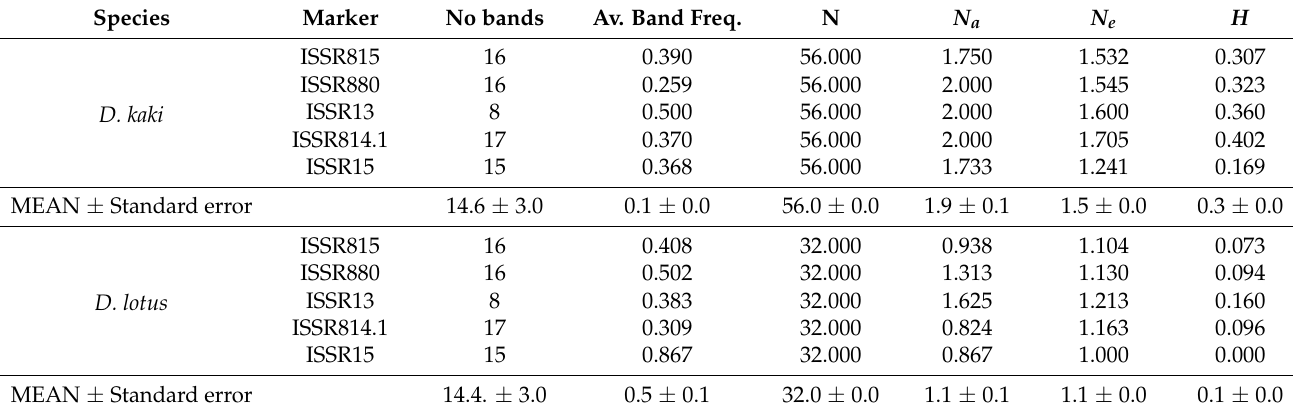
Table 2. Genetic diversity parameters for the selected ISSR